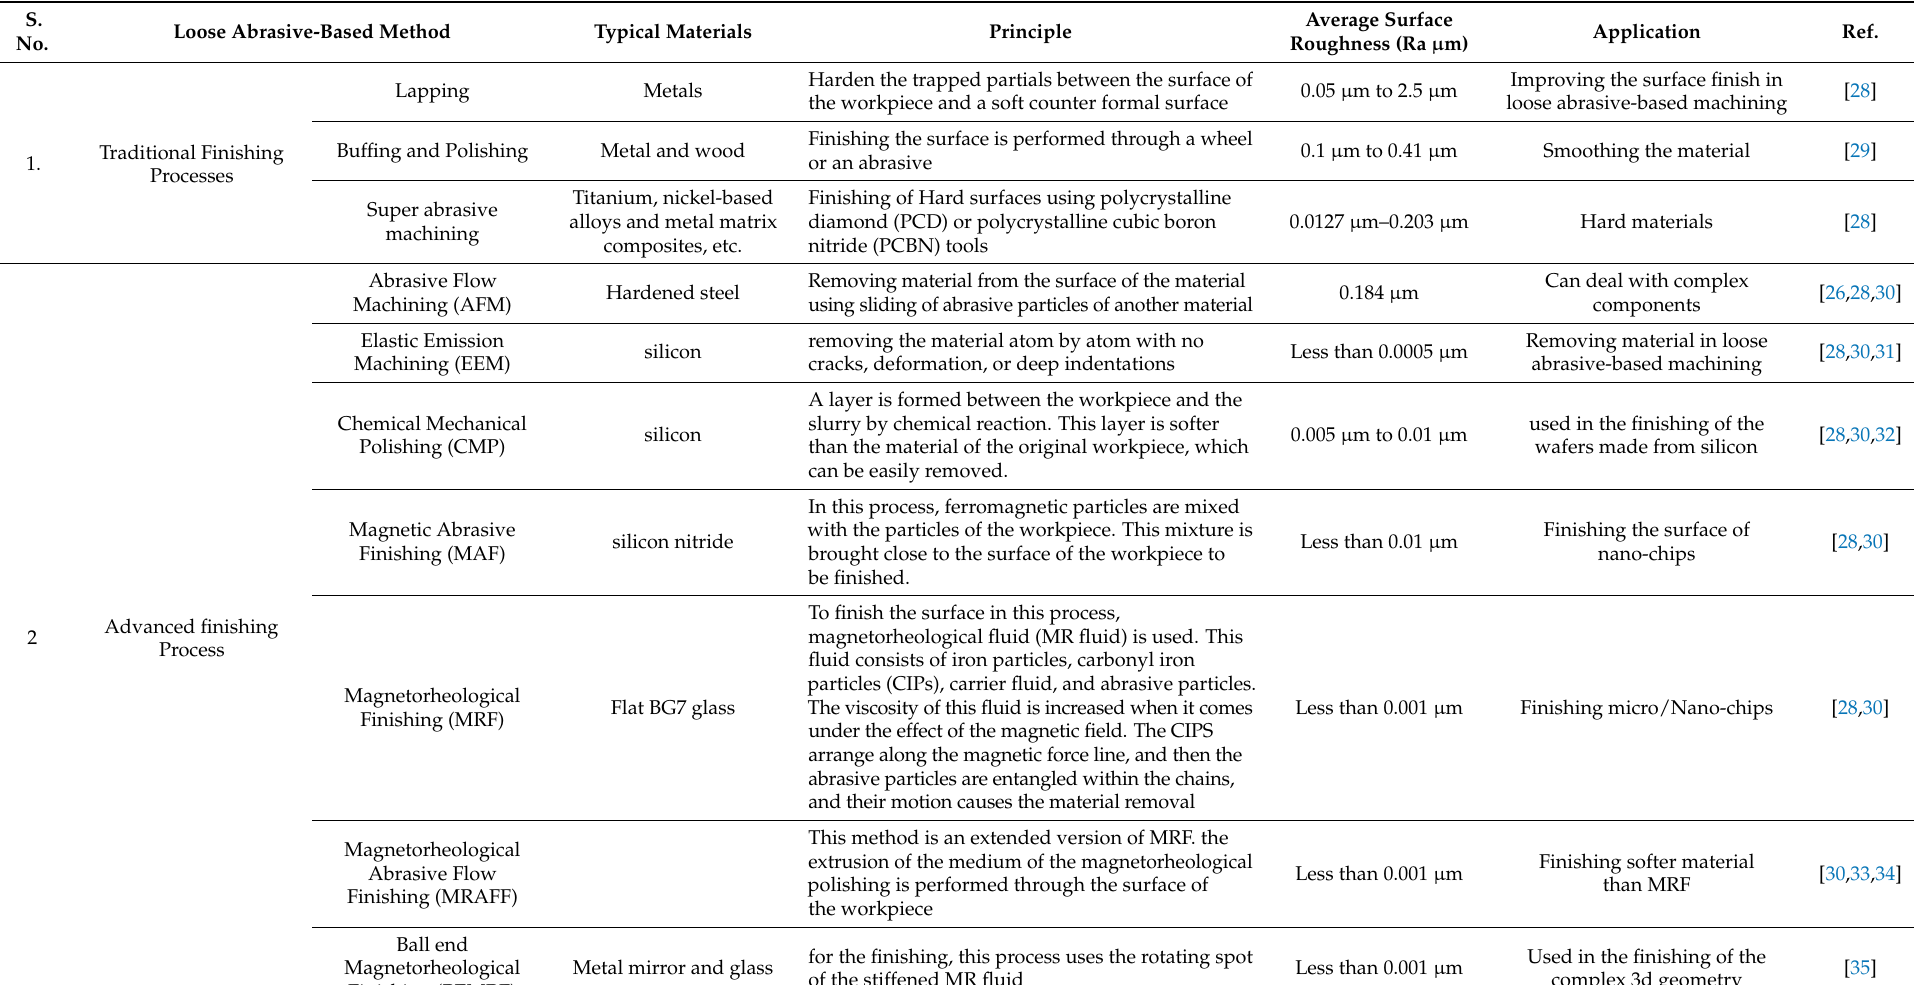
Table 1. Literature summary of loose abrasive-based Machining process with basic principle and process